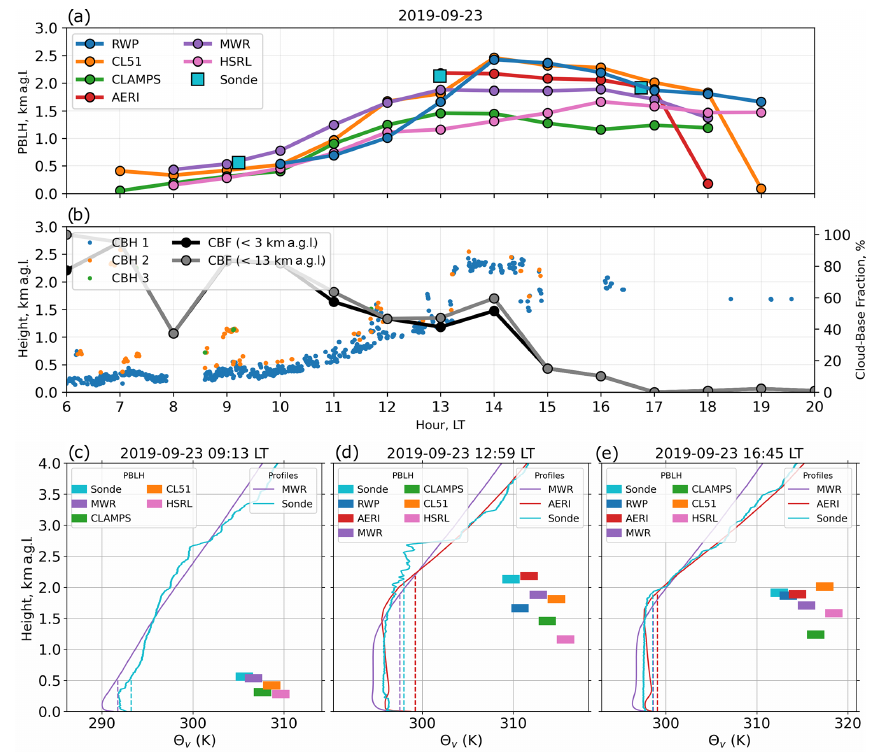
Figure 16. The same as in Fig. 15 but for 23 September 2019 and with CLAMPS